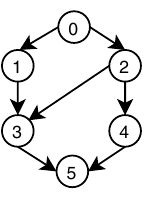
Fig. 1 Example DAG